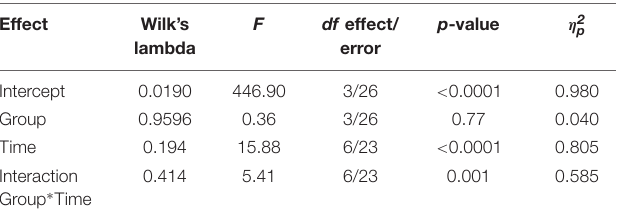
TABLE 4 | Multivariate model of RM ANOVA with the variables ‘highest pressure,’ ‘area,’ and ‘load’ for the left side of the pelvis